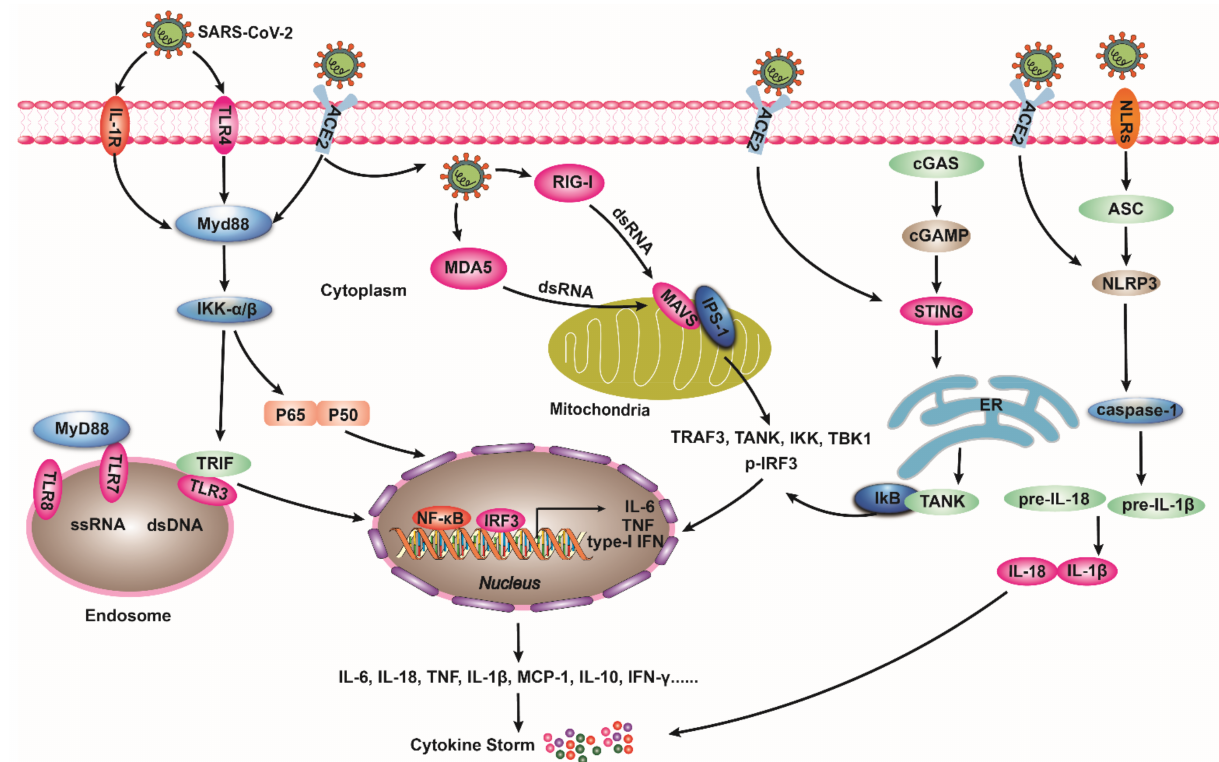
Figure 3. The major signal pathways of immunity against SARS-CoV2 infection. (i). TLRs primarily activate the transcription of NF- κ B through MyD88 and TRIF-dependent pathways, which leads to the secretion of inflammatory factors and type-I IFN. (ii). RIG-I and MDA5 recognize the dsRNA in the cytoplasm and activate the downstream mitochondrial antiviral- signaling protein (MAVS) and IPS-1. Immune response is induced, including the activation of NF- κ B and IRF3 transcription. (iii). cGAS identifies the dsDNA of the virus, thus inducing the production of the second messenger cyclic guanosine monophosphate adenosine monophosphate (cGAMP), which binds to STING on the endoplasmic reticulum membrane to cause an inflammatory response. As a member of the NLRs family, NLRP3 activates caspase-1, resulting in the cleavage of pre-IL-1 β and pre-IL-18 to generate IL-1 β and IL-18 in the lung inflammatory response. Abbreviations: TLRs, Toll-like receptors; MDA5, melanoma differentiation-associated